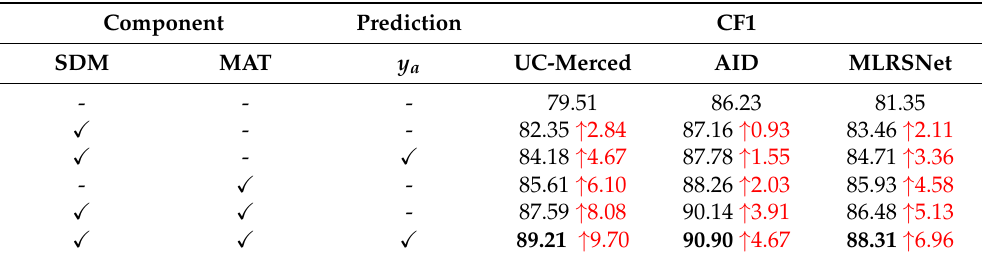
Table 4. Ablation studies on the essential components of our proposed method. The symbol (cid:88) represents the component in this column is in use. The red font denotes the improvement over the baseline. The bold means the best performance.